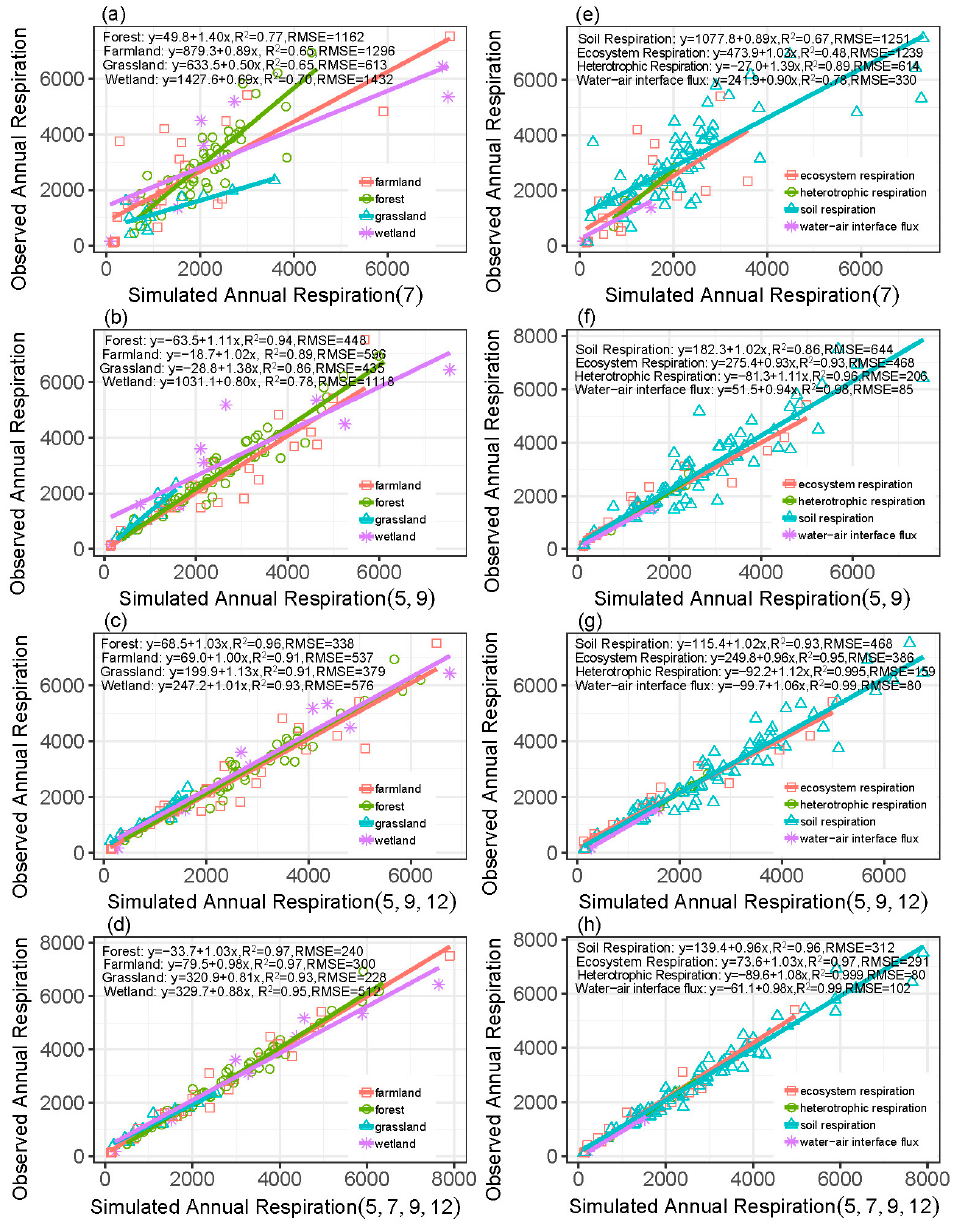
Figure 6. Comparison of the observed and estimated annual soil / ecosystem respiration using 1 to 4 monthly respirations of different types of ecosystem ( a – d ) and interface ( e – h ). Derived using Equations (B1)–(B4) in Table 3 and test data (not used in equation development). Respiration and RMSE unit: g CO 2 m − 2 yr − 1 .